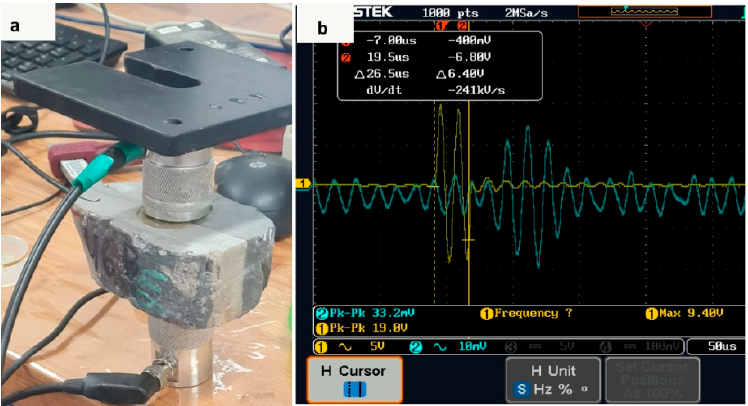
Figure 10. ( a ) The assemblage of chert sample and two ultrasonic sensors; ( b ) the typical shape of transmitted (yellow) and received (blue) ultrasonic pulses.